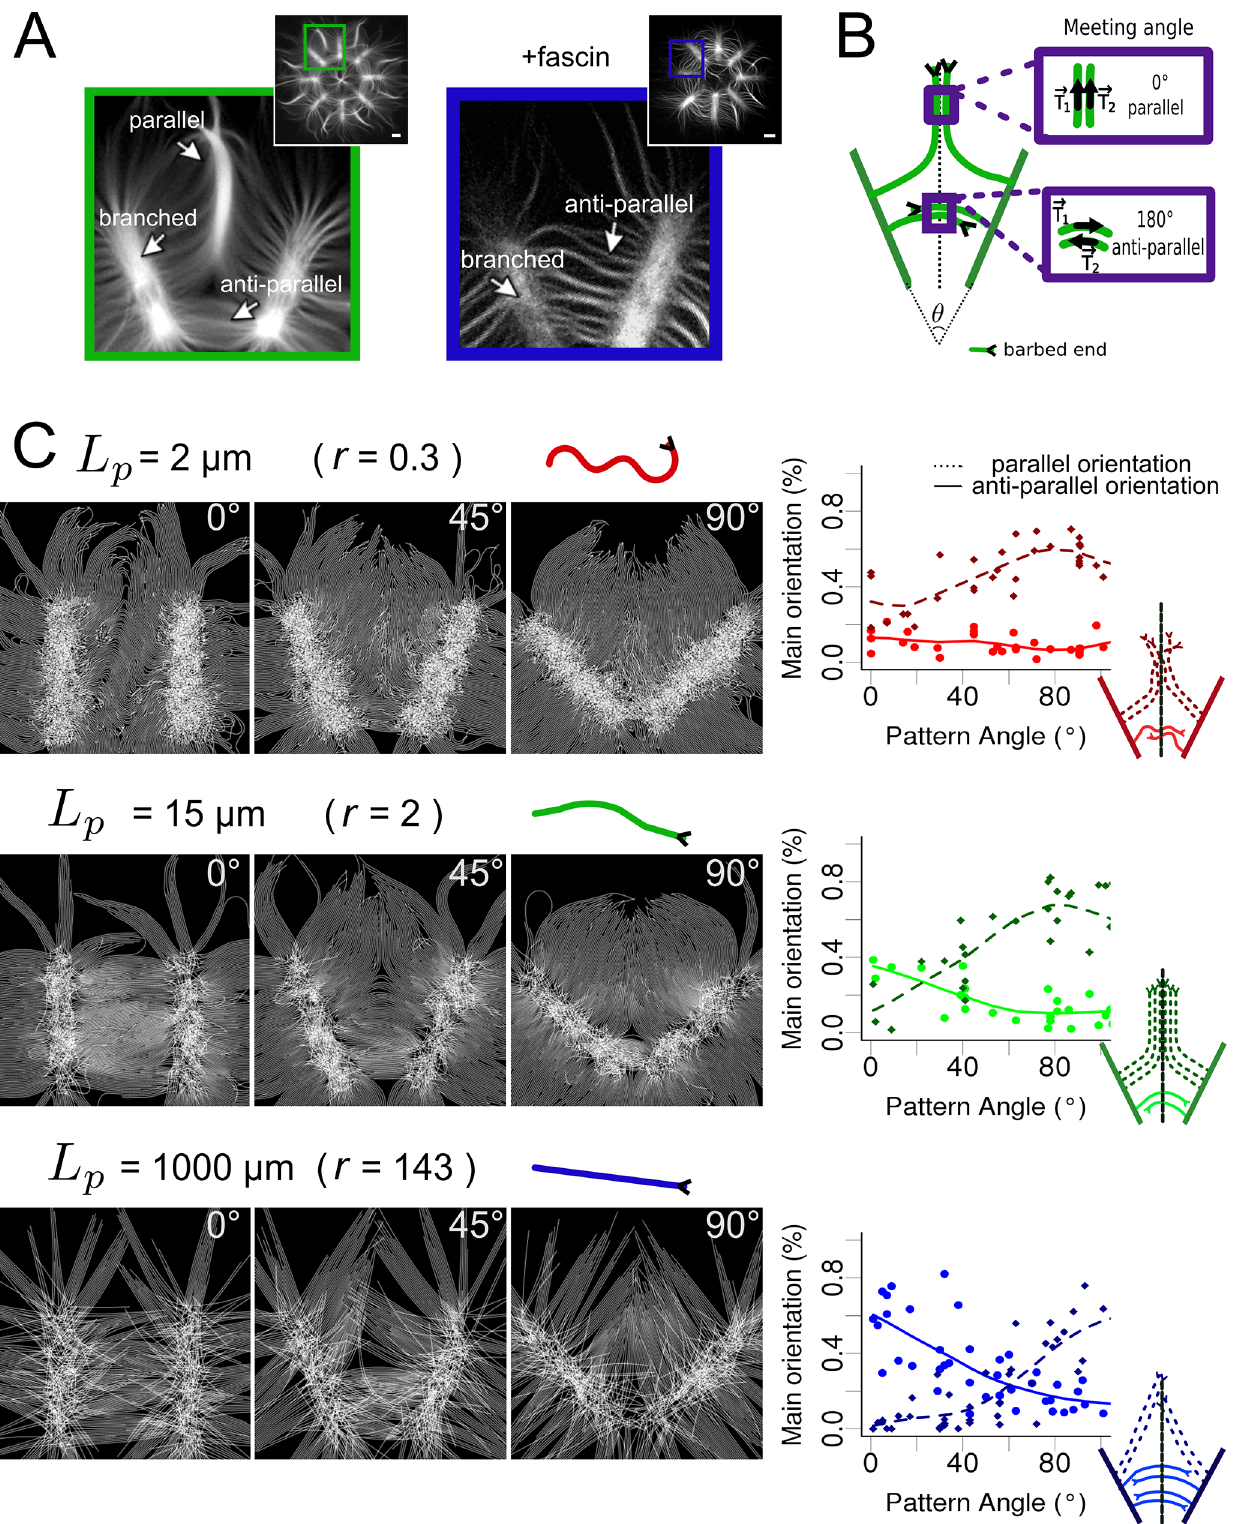
Fig 2. Effect of geometrical constraints and fiber mechanical properties on fiber organization. (A) in vitro actin filament organization from a star eight- fold radial array pattern coated with pWA activator, in absence (green) or presence (blue) of fascin, an actin filament cross-linker. A portion of the pattern